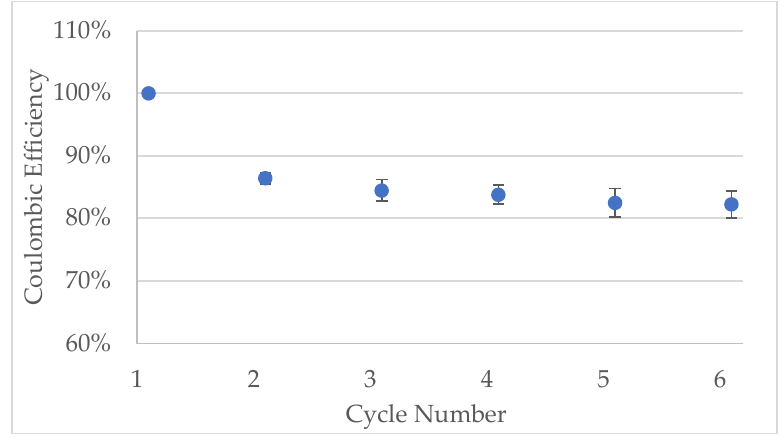
Figure A7. Specific capacities of the half-cells made with Kuranode hard carbon containing 2% car- bon black. The bars represent the standard deviations of three cells.